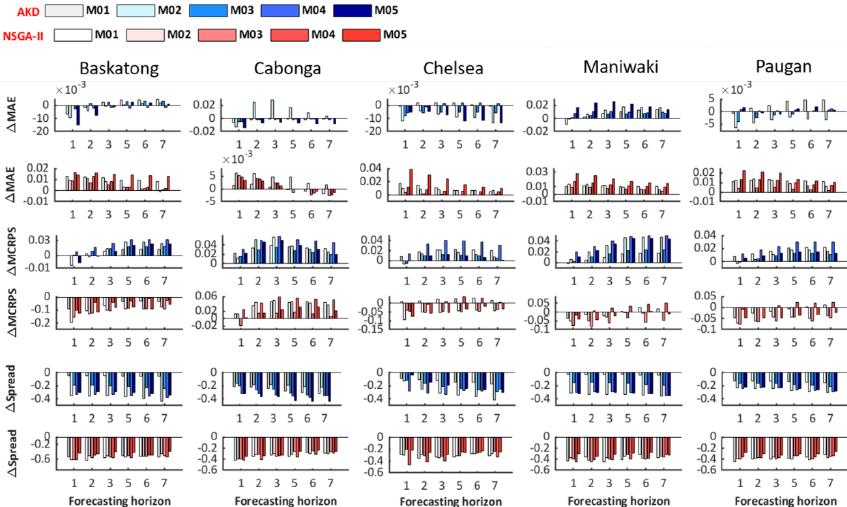
Figure 10. Comparison of the MAE, MCRPS, and ensemble dispersion of the raw, AKD, and NSGA-II forecasts (i.e., 1–3 and 5–7d ahead forecasts) for five singe-model H-EPSs over all catchments (January 2011–December 2016). The x axis for each sub-plot represents different